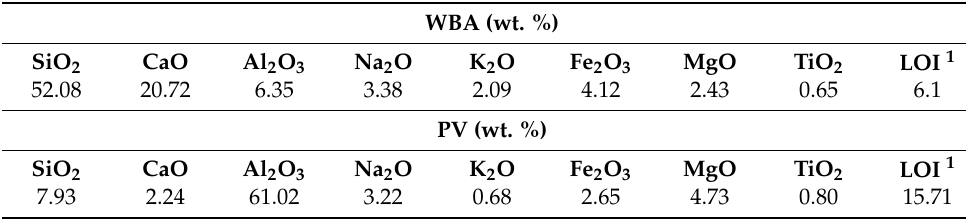
Table 1. Major and minor elements composition of weathered bottom ash (WBA) and PAVAL ® (PV) powders. WBA (wt. %) SiO